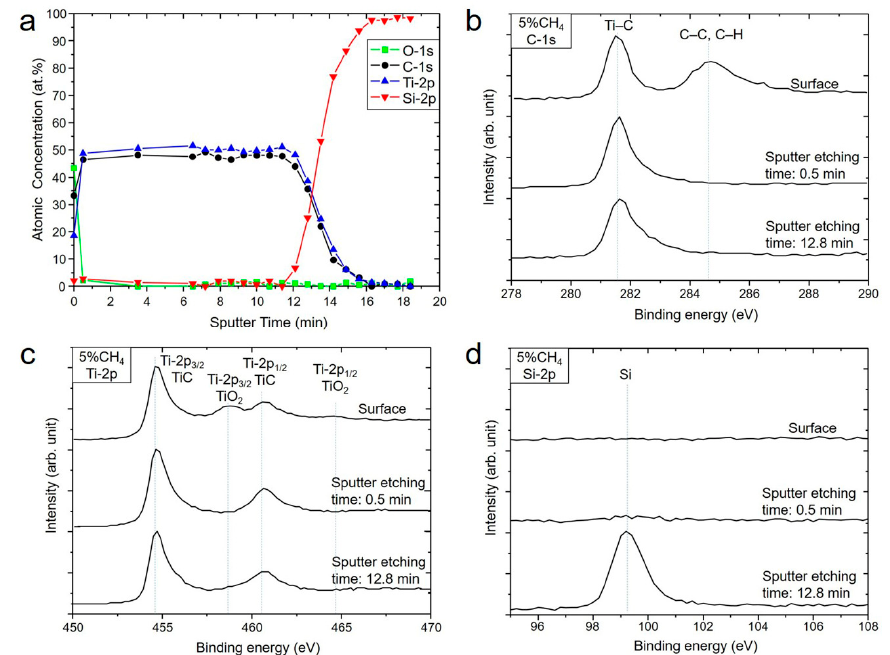
Figure 7. XPS data for 5% CH 4 . ( a ) Depth profile, and spectra showing ( b ) C-1s, ( c ) Ti-2p, and ( d ) Si-2p at di ff erent depth in the TiC film. The intensity has been normalized.